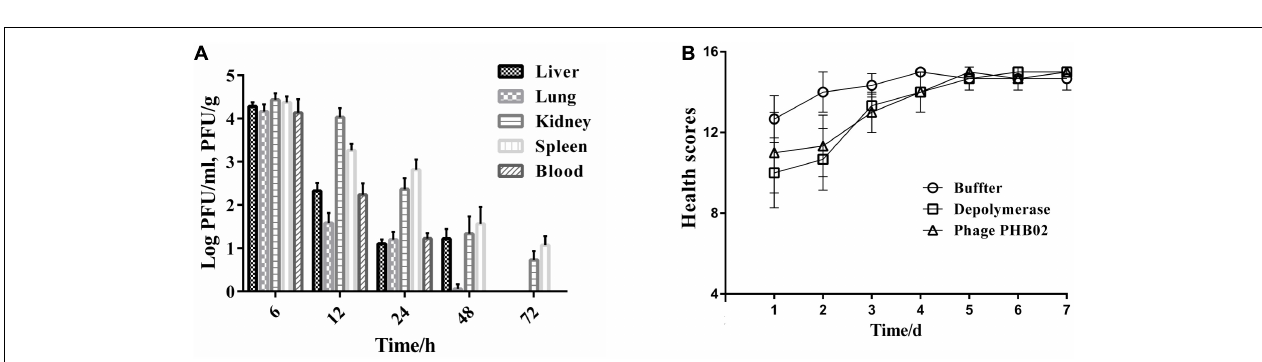
FIGURE 3 | Serum sensitivity assay. (A) P. multocida strain HB03 mixed with depolymerase was incubated with mouse serum or whole-blood. (B) P. multocida strain HB03 with depolymerase was incubated with human serum. The mixtures were incubated at 37 ◦ C for 2 h. The number of viable bacteria was determined by plating and enumeration of serial dilutions of the suspension. Assays were repeated at least three times. Experimental data were analyzed by one-way analysis of variance and are expressed as the mean ± SD. The viable cell counts in each of the treatment groups were compared with that of the PBS control, with significant differences indicated by ∗ P < 0.05; ∗∗ P < 0.01; and ∗∗∗ P < 0.001.